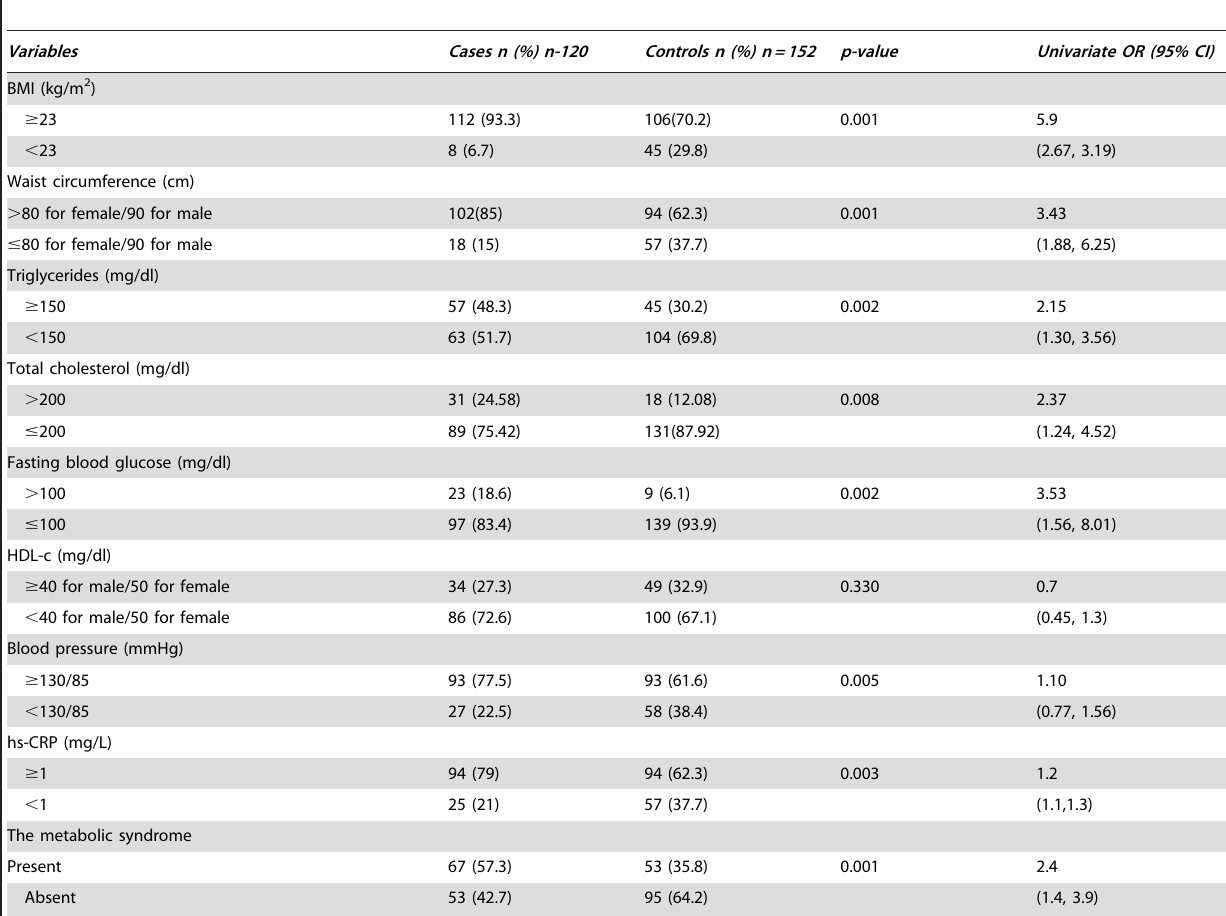
Table 4. Logistic Regression Analysis with hs-CRP as the Outcome Variable and Anthropometric and Metabolic Variables as Co-